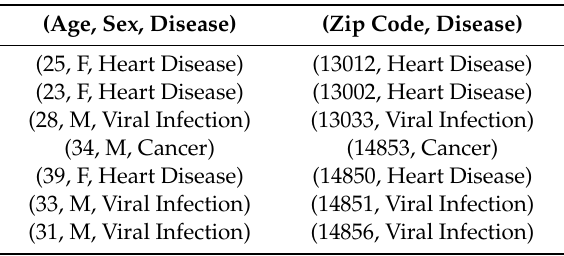
Table 6. Table after overlapped